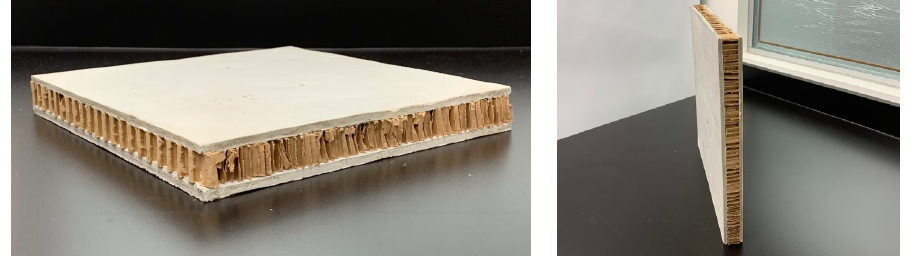
Figure 2. The laboratory view of the honeycomb sandwich structure.